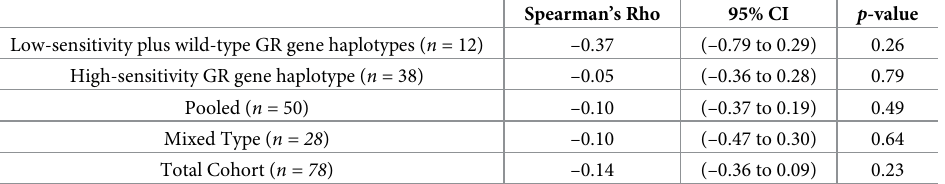
Abbreviations: CI, confidence interval; GR, Glucocorticoid